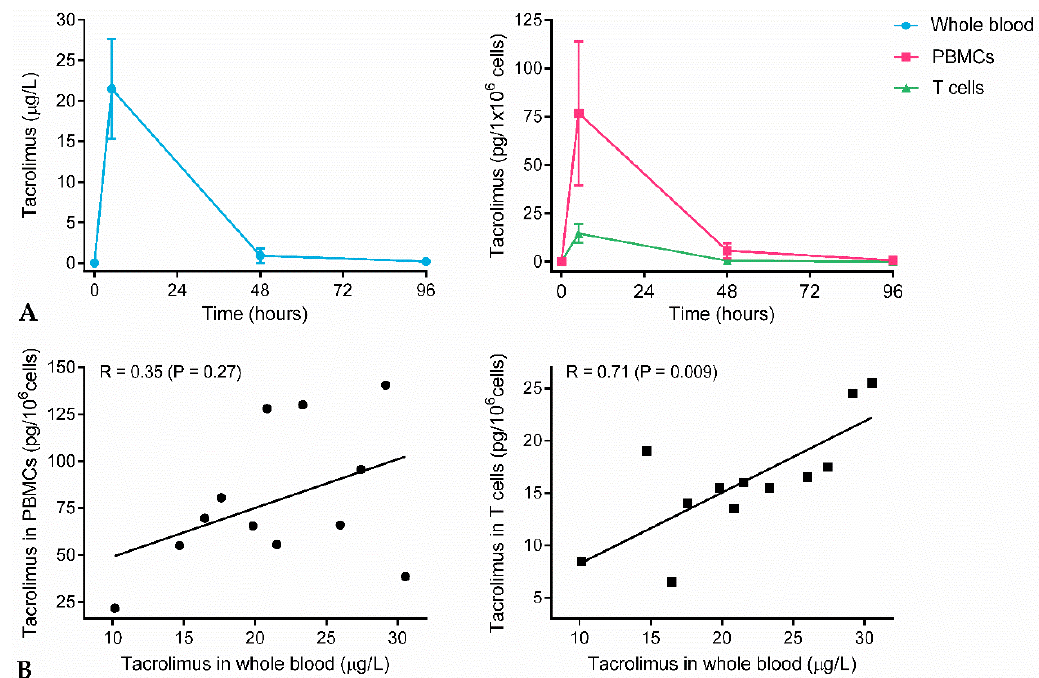
Figure 1. ( A ) Mean tacrolimus concentration over time in whole blood, PBMCs, and T cells. Samples were taken at 0 h, 1.5 h, 48 h, and 96 h post-dose. ( B ) Correlation between tacrolimus concentrations at 1.5 h post-dose in whole blood and PBMCs, and between whole blood and T cells.